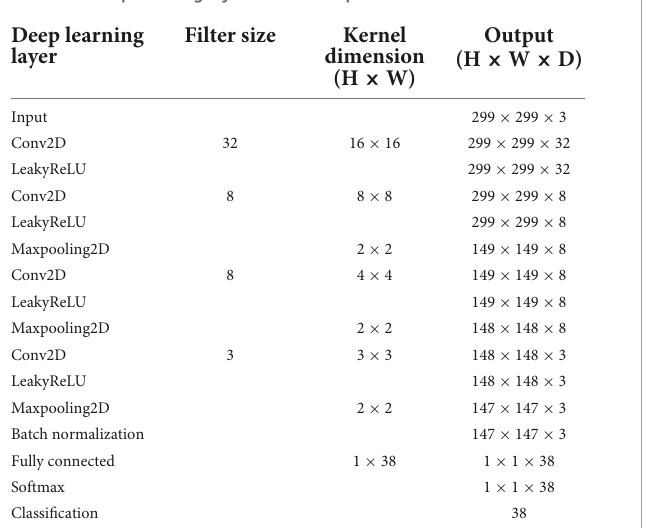
(Jang et al., 2008). The duration of each sentence was 1.8 ± 0.2 s, and the number of phonemes in each sentence was 18.6 ± 3.9.